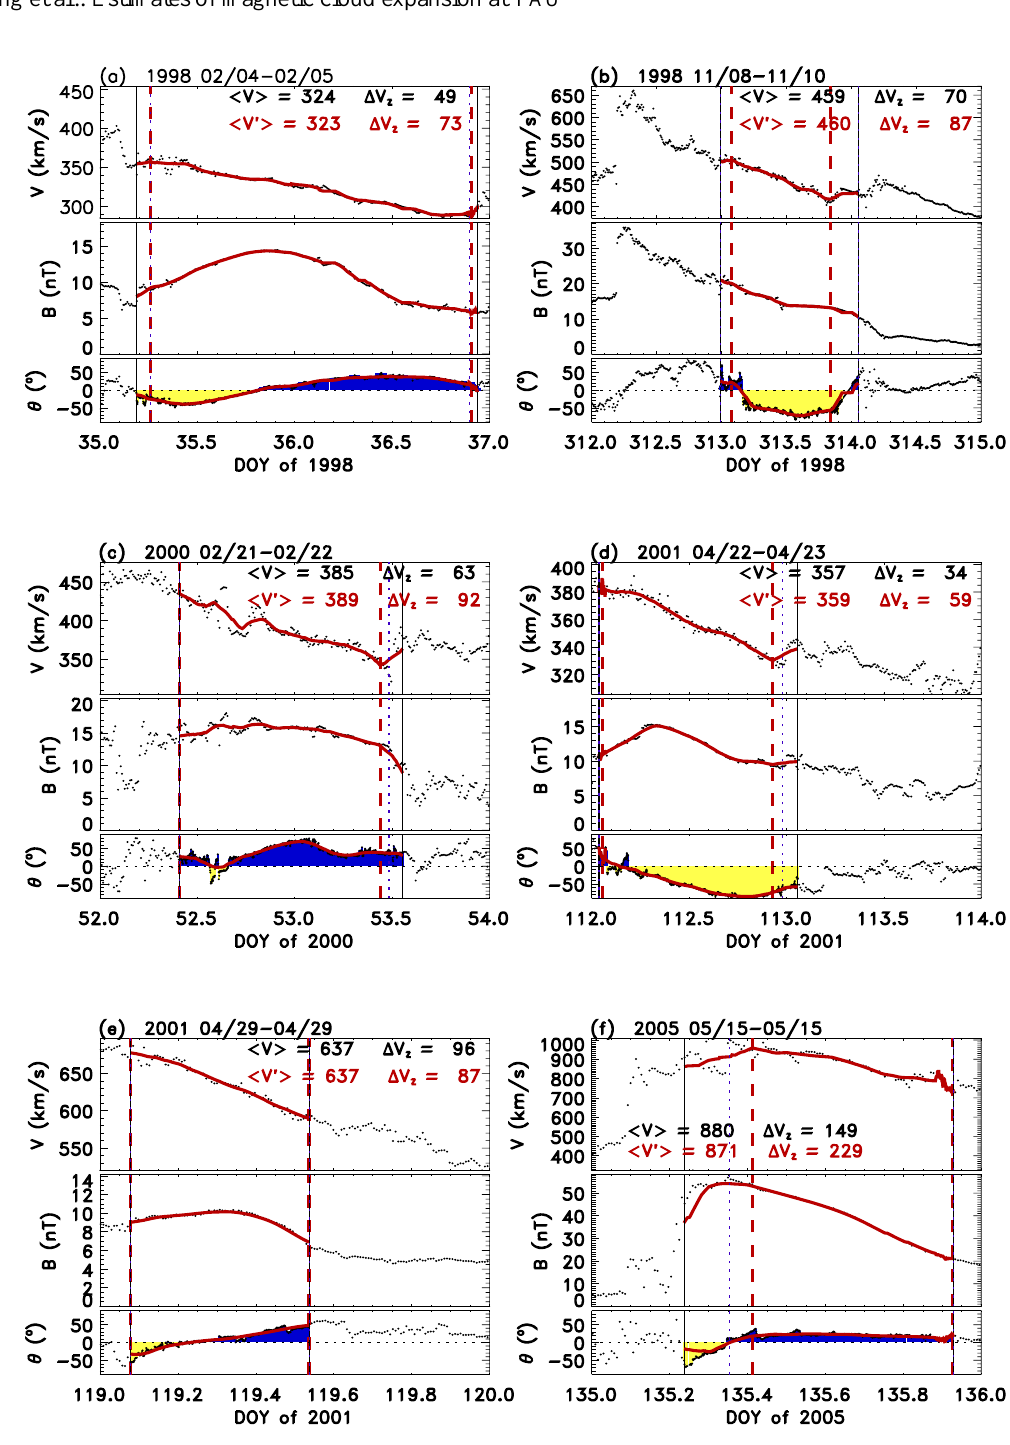
Fig. 2. Six examples of the profiles of plasma speed ( V = | V | ) , magnetic field magnitude ( B ), and field latitude angle ( θ) as the WIND spacecraft passes through a MC. All data presented in 10-min average form. Black solid vertical lines indicate the identified start and end times of the MC; dotted vertical (blue) lines indicate choices, through visual inspection, of the points of MAX and MIN in the speed profile; and dashed (red) vertical lines are points of MAX and MIN chosen automatically, via computer searching, after V is smoothed via a running average of 2h length. Average speed is given in the V-panel, as <V > for an average over the full MC and as <V 0 > (in red) for the 1t 0 region, both in units of km/s. Panels (a) through (f) are ordered according to date: (a) is the MC with start day of 4 February 1998, (b) is for 8 November 1998, (c) is for 21 February 2000, (d) is for 22 April 2001, (e) is for 29 April 2001, and (f) is for 15 May 2005. In each θ -panel the regions where the magnetic field goes southward are in yellow and when northward they are in